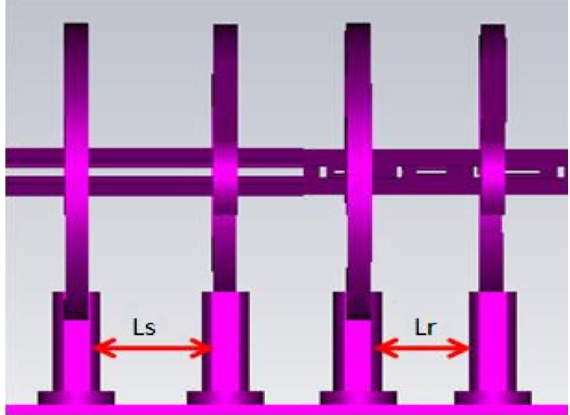
FIG. 5. The 3D illustration of the coupled